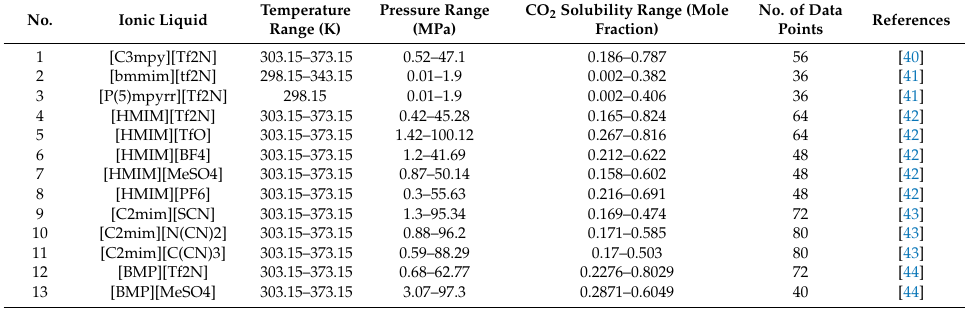
( w ), as summarized in Table 2. These 6 input parameters were hence used for predicting the dissolved mole fraction x of CO 2 . All the 744 experimental data points were randomly divided into a training data set (80% of the database) and a test data set (20% of the database). Table 1. Ranges of observed temperature, pressure, and CO 2 solubility measurements of the ionic liquids used in this study.